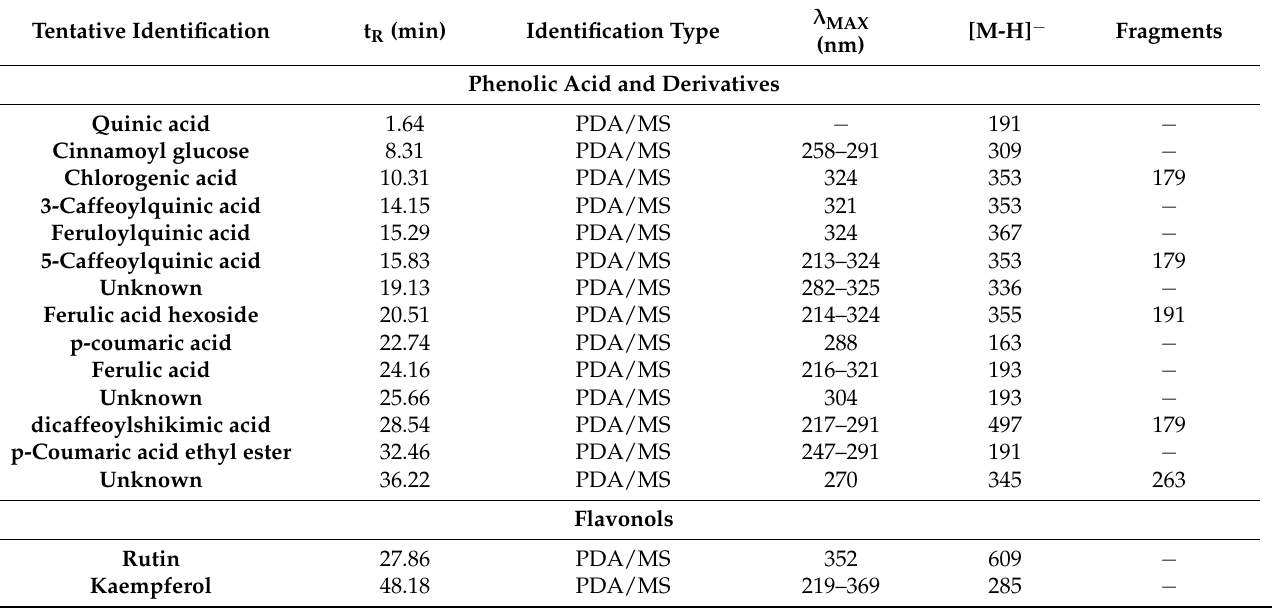
Table 5. Polyphenolic compounds detected in EtOAc extract of C. humilis by HPLC–PDA–ESI/MS.